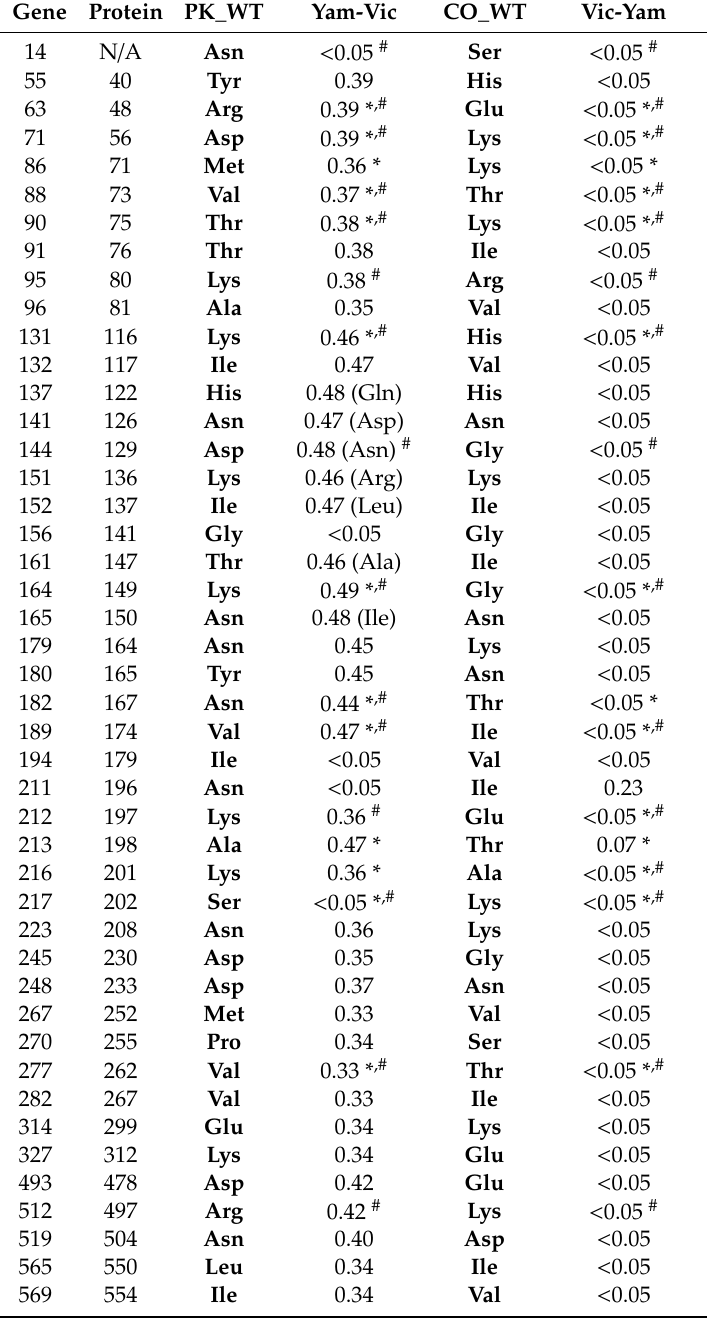
Table 3. Frequency of subpopulations in wild-type viruses encoding alternative sequence. The table provides information about the position of the codon (gene) and the amino acid excluding the signal peptide (protein) using the numbering for Yamagata virus B / Phuket / 3073 / 2013 (PK-WT). The Victoria lineage B / Colorado / 06 / 2017 (CO_WT) sequence has one less codon (codon position 177 and amino acid position 162). The consensus amino acids for PK_WT and CO_WT at the indicated positions are shown. The frequency of nucleotide variants that encode an alternative amino acid are shown in the adjacent columns. Unless otherwise indicated the most frequent alternative amino acid is that of the other virus lineage (shown in bold font). * two nucleotide changes required; # two nucleotides in codon changed at same frequency in escape